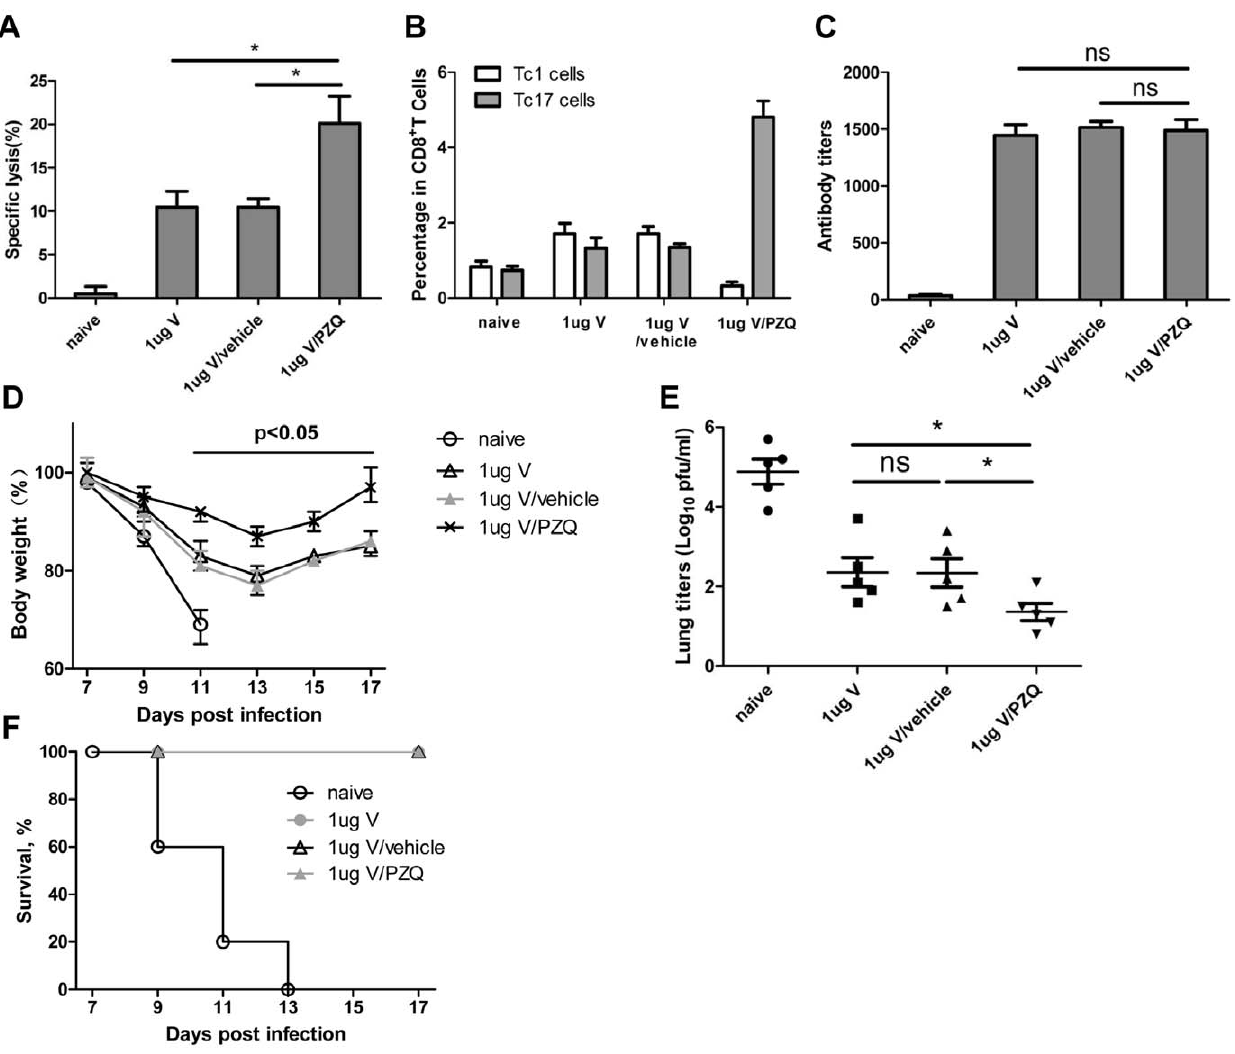
Figure 5. Effect of adding PZQ to high-dose (1 m g) killed H5N1 vaccine. Mice were immunized with high-dose killed H5N1 vaccine (0.5 m g PZQ/1 m g antigen). (A) In vivo cytotoxic lysis assay performed on day 7 after primary immunization. (B) The percentage of Tc cells at day 7. (C) Antibody levels in sera collected on day 14 after immunization and assayed by ELISA. (D) Weight change of surviving mice and (E) viral loads in the lungs. Mice were infected x days after immunization and viral load was measured 7 days later. (F) Survival curves. Data are analyzed from three separate experiments and each had 5 animals. *, p , 0.05. ns, p . 0.05. 1 m g V stands for 1 m g killed H5N1 vaccine.